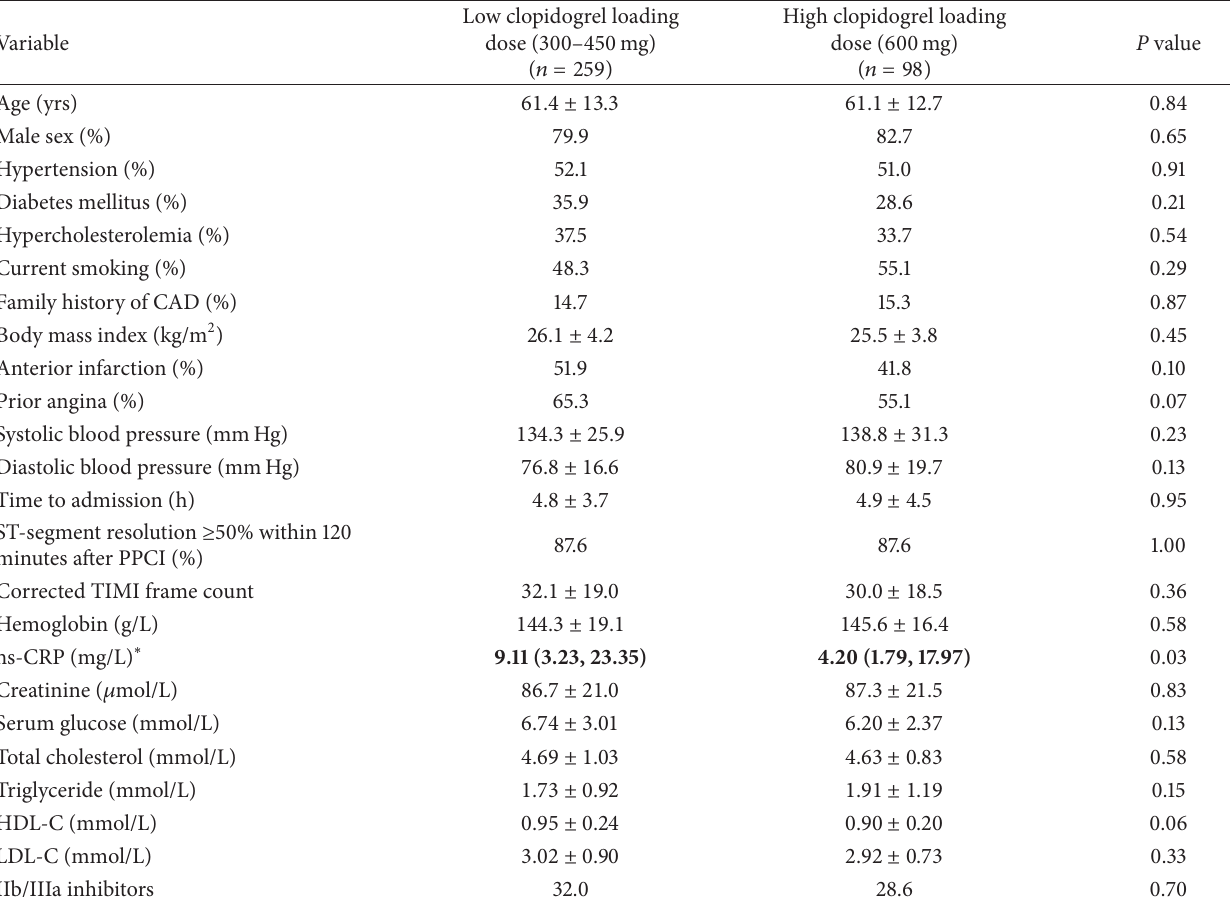
Table 1: Baseline